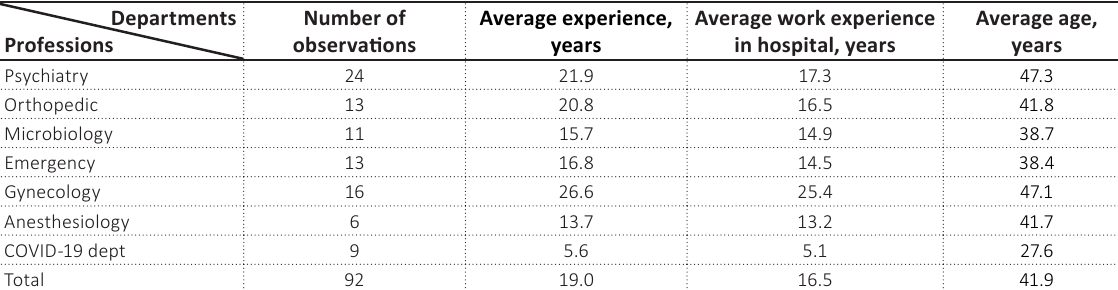
Table 1. Characteristics of the